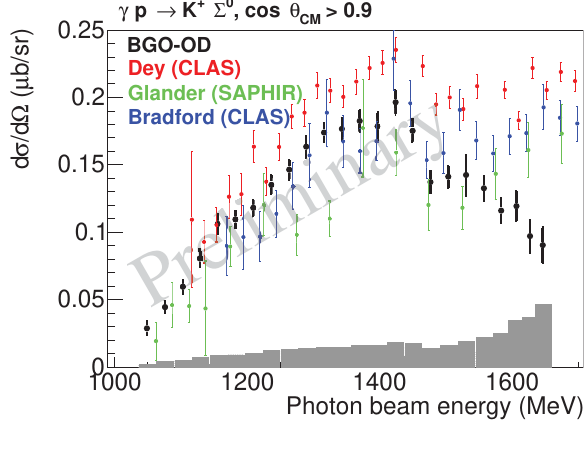
Figure 19. γ p → K + Σ 0 di ff erential cross section for cos θ CM > 0 . 9 (Black points). Systematic errors are the filled grey bars on the abscissa. Previous data of Dey [45], Glan- der [42] and Bradford [41] shown in red, blue and green respec- tively. The data of Dey and Bradford are at the more backward interval, 0 . 85 < cos θ CM < 0 . 95.